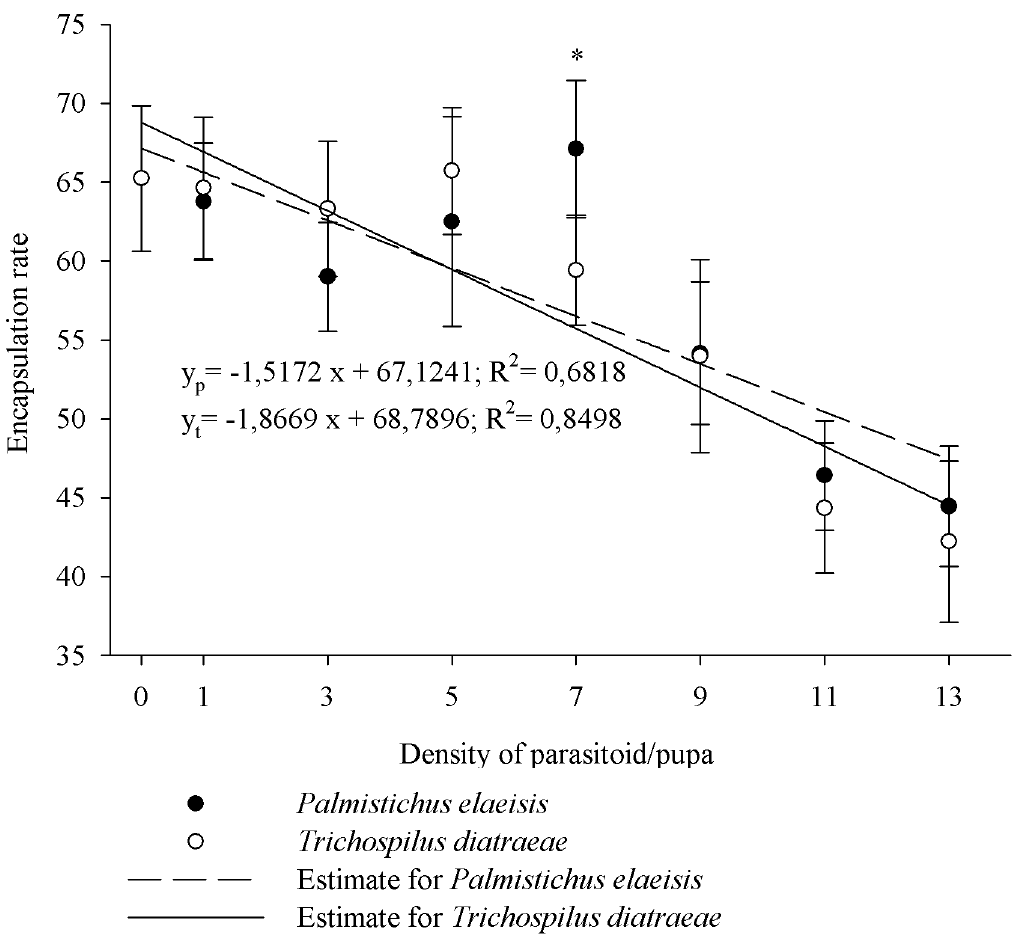
Figure 5. Encapsulation rate pupae of Anticarsiagemmatalis pupae parasitized by densities of Palmistichuselaeisis or Trichospilus diatraeae .